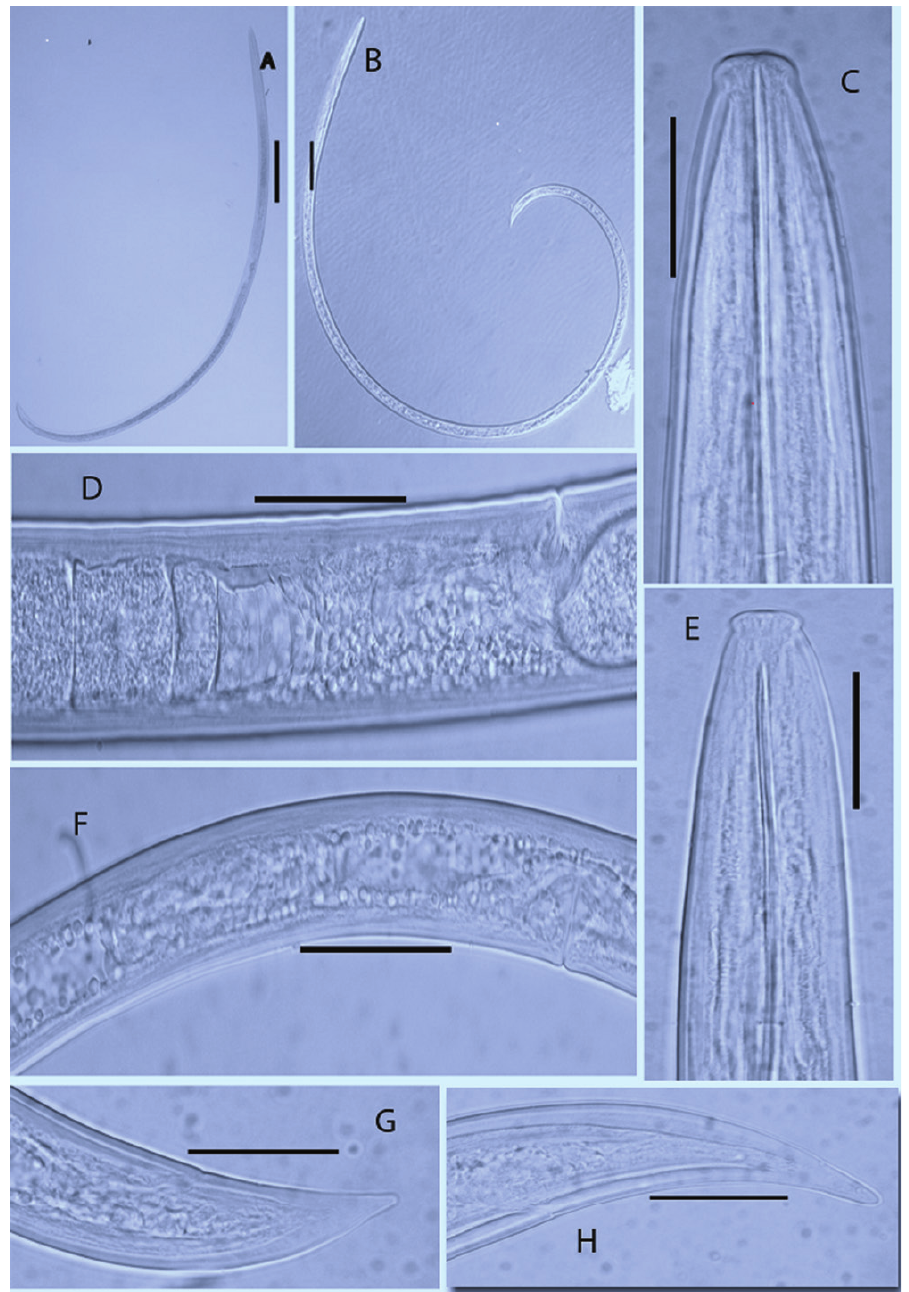
Figure 1. Photomicrographs of X. elongatum and X. pachtaicum . A, C, D, H Body habitus, head region, entire female reproductive part, tail region of X. elongatum respectively B, E, F, G Body habitus, head region; female reproductive part and tail part of X. pachtaicum respectively. A = 250 μ m; B = 100 μ m; D, F = 50 μ m; C, E, G, H = 25 μ